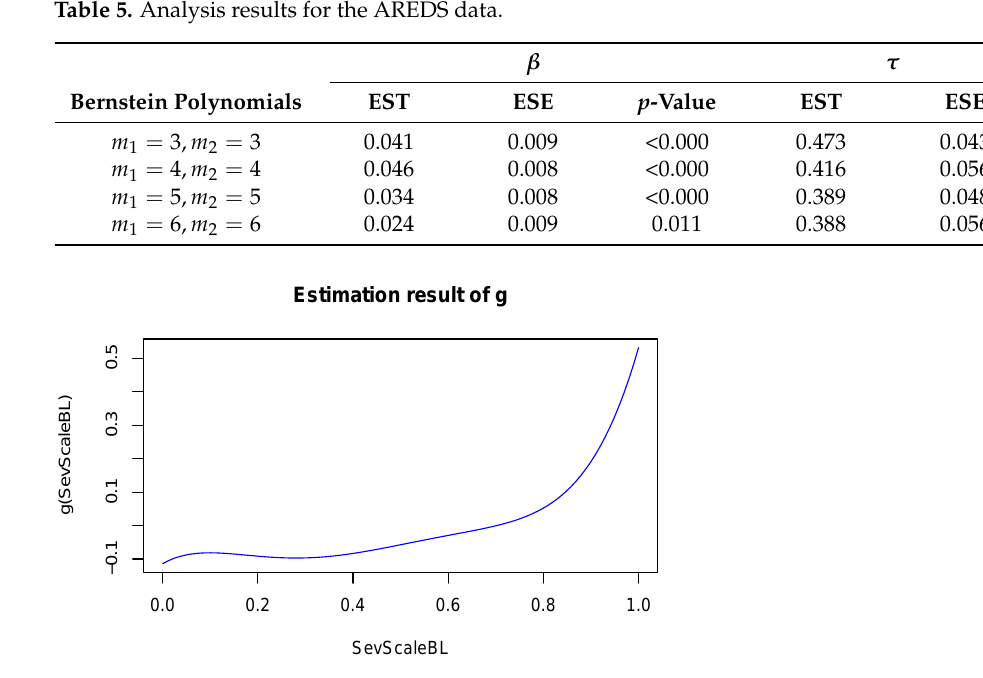
Figure 3. Estimated nonlinear effect of SevScaleBL for the